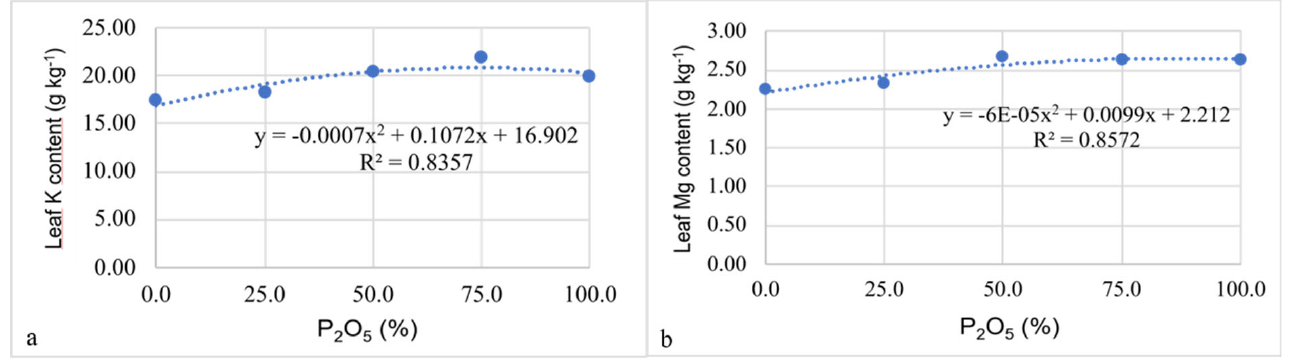
Figure 3. Plots of the fitted regression equations for foliar K in 2019 ( a ) and foliar Mg in 2020 ( b ) in corn plant as a function of phosphate fertilization.